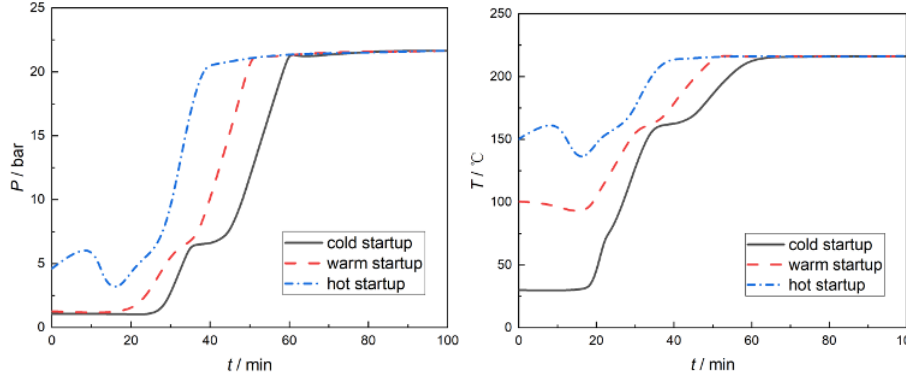
Fig. 4. IP drum start-up